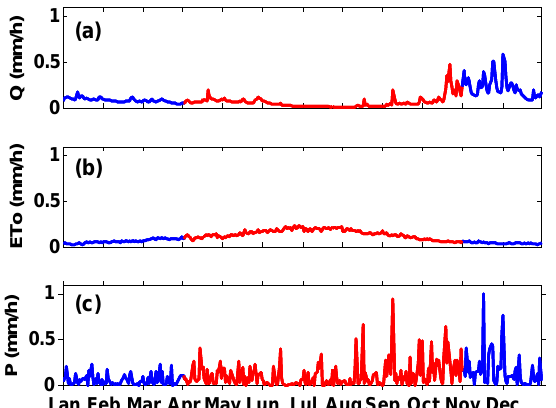
Figure 3. Average hourly discharge (a) , reference ET 0 (b) and rain- fall (c) in (mmh − 1 ) at the Ardèche outlet for all months between 2000 and 2008. (b) and (c) are calculated from the SAFRAN re- analysis. In red: vegetation period; in blue: low-vegetation